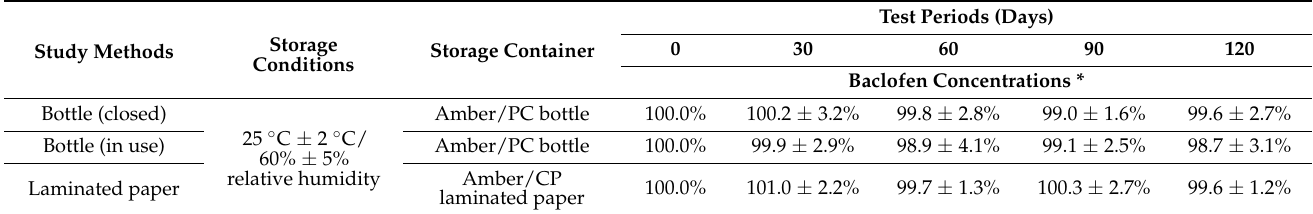
Table 1. Compounded baclofen stability.